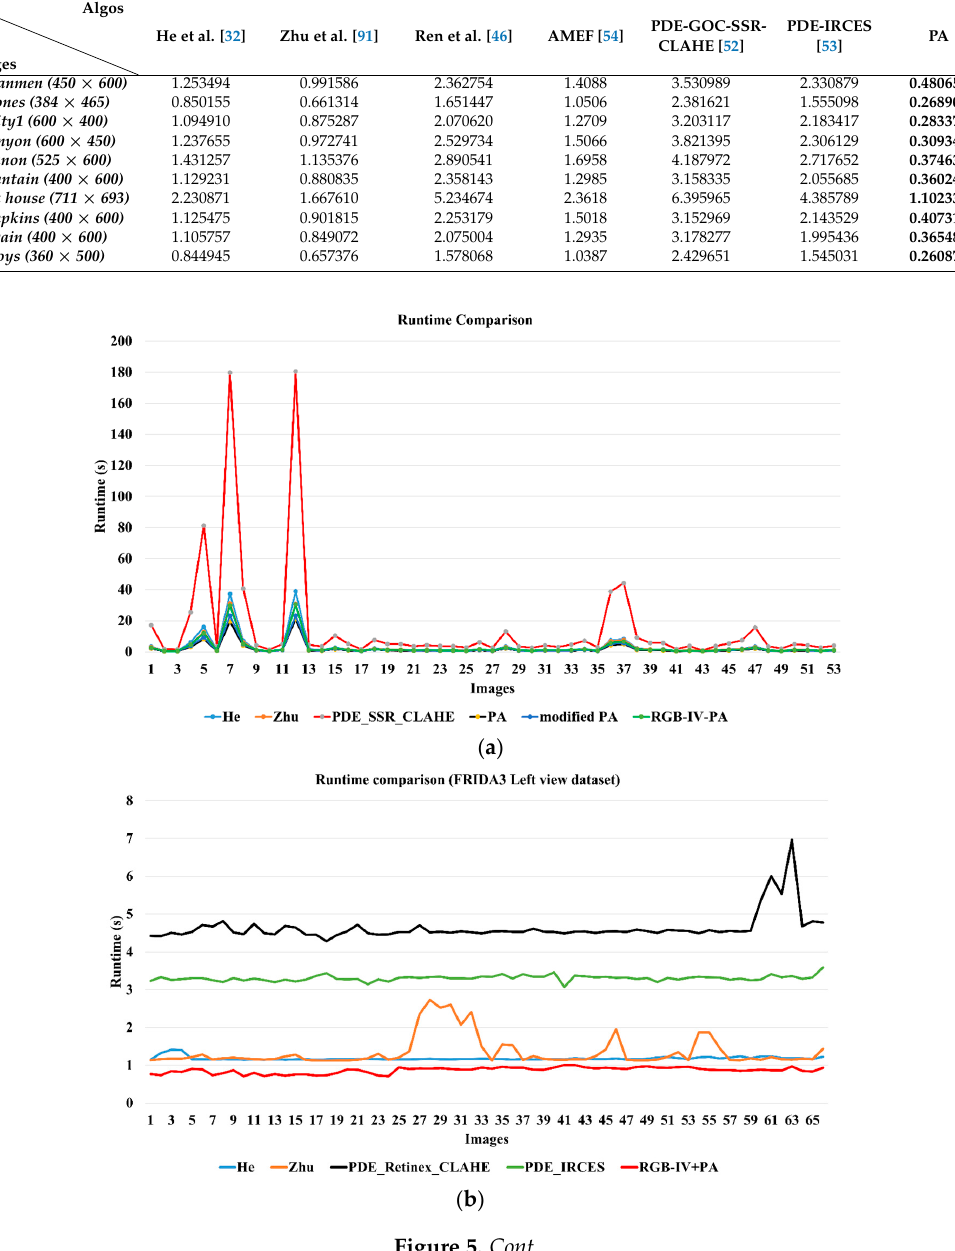
( c ) Figure 5. Runtime comparison of various algorithms using ( a ) 53 real and 66 synthetic ( b ) left and ( c ) right view hazy images. 4. Visual Comparison of AMEF and PA and Discussion The key components of the enhancement capability of AMEF are the CLAHE and Gamma Correction (GC) algorithm. Unlike the PDE-GOC-CLAHE, which included the CLAHE and minimized its negative effects [52], the AMEF does not possess such features. We directly compare